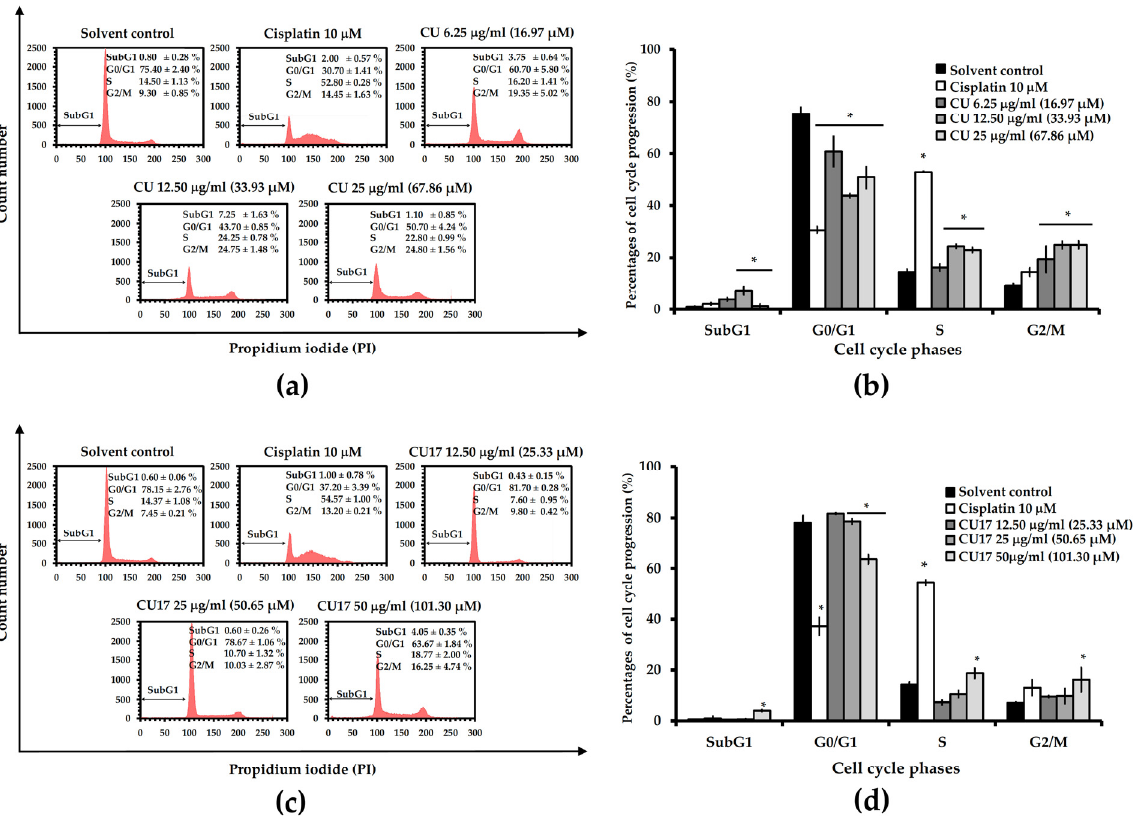
Figure 5. Effect of CU and CU17 on cell cycle progression of A549 cells for 24 h. ( a , c ) Cellular DNA histograms exhibit the cell cycle distribution of A549 cells after CU or CU17 treatment. ( b , d ) Bar graphs displayed the mean of percentages of cell cycle distribution from three independent experi- ments. A549 cells treated with DMSO: ethanol (1:1, v / v ) and cisplatin (10 µM) were used as negative and positive controls, respectively. * p < 0.05 indicates a significant difference between the treatment and solvent control.